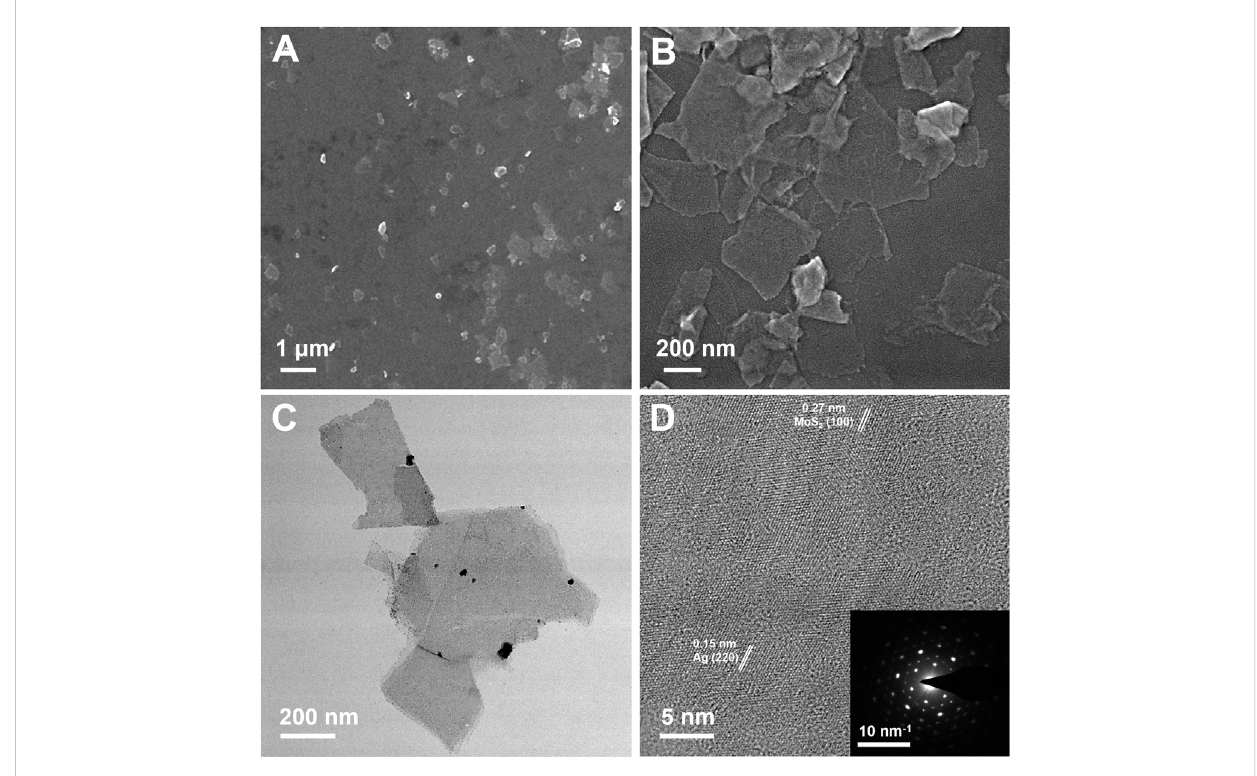
FIGURE 1 (A, B) SEM, (C) TEM, and (D) HR-TEM images of MoS 2 /Ag3 nanosheets. Inset in (D) is the SAED pattern of MoS 2 /Ag3